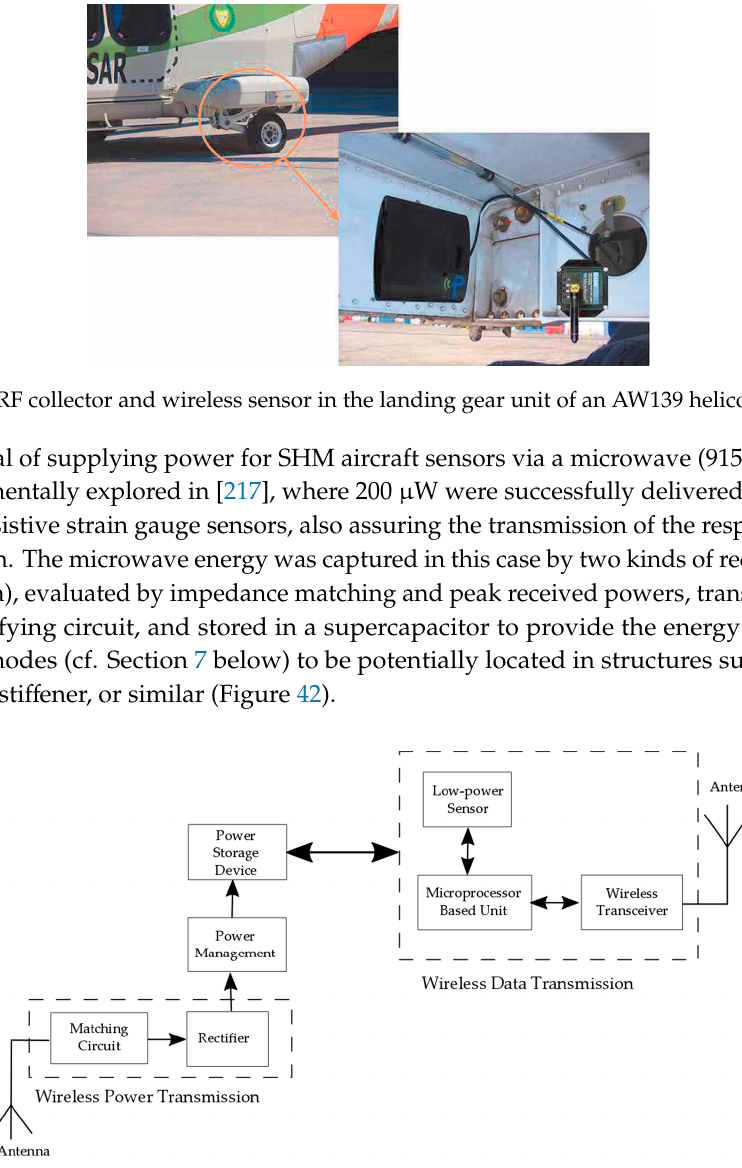
Figure 42. Block diagram of an RF-powered wireless sensor node with the data transmission system.